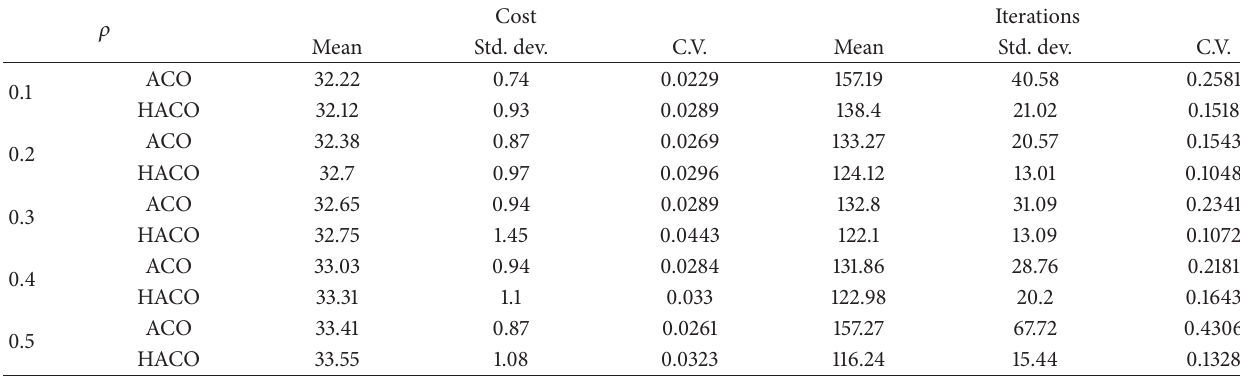
Table 4: Results with different 𝜌 (cost: million CNY; iterations: number).